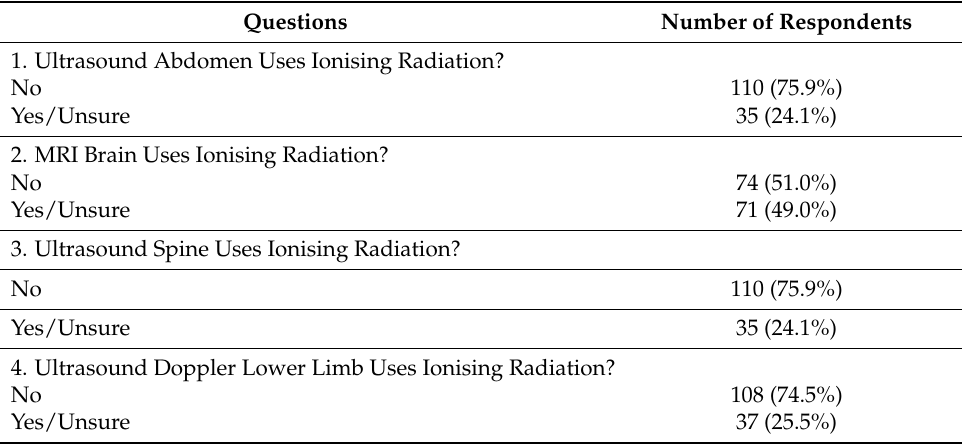
Table 3. Summary of questionnaire responses on dose-saving medical